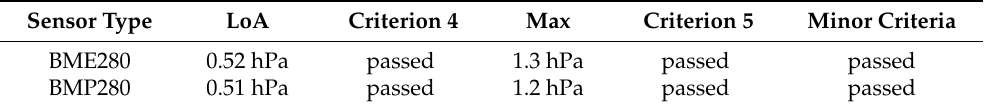
Table 8. Comparison of worst-case differences between data from atmospheric pressure sensors and data from the reference weather